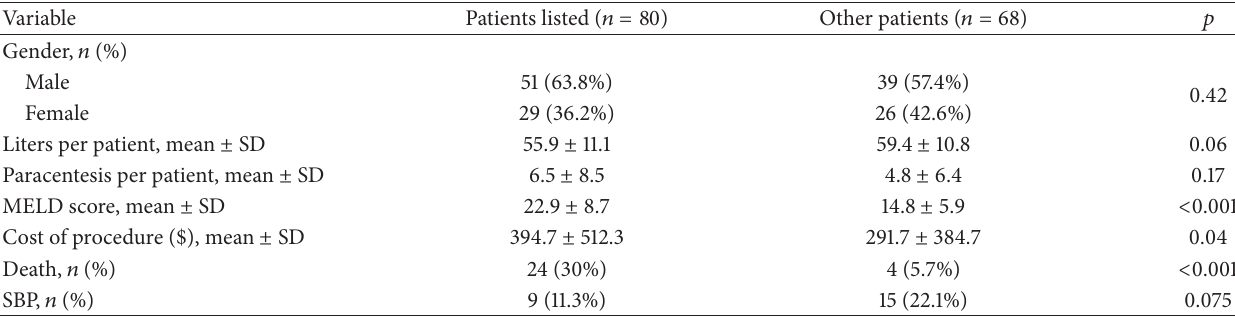
Table 2: Comparison between patients listed for liver transplantation and other